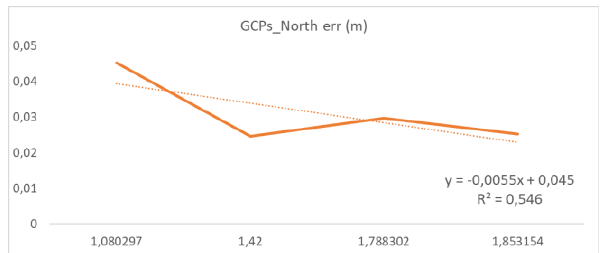
Figure 9. Predictive function extracted linearly interpolating the depend (synthetic index) and independent variables (northern error component). R 2 : coefficient of determination.